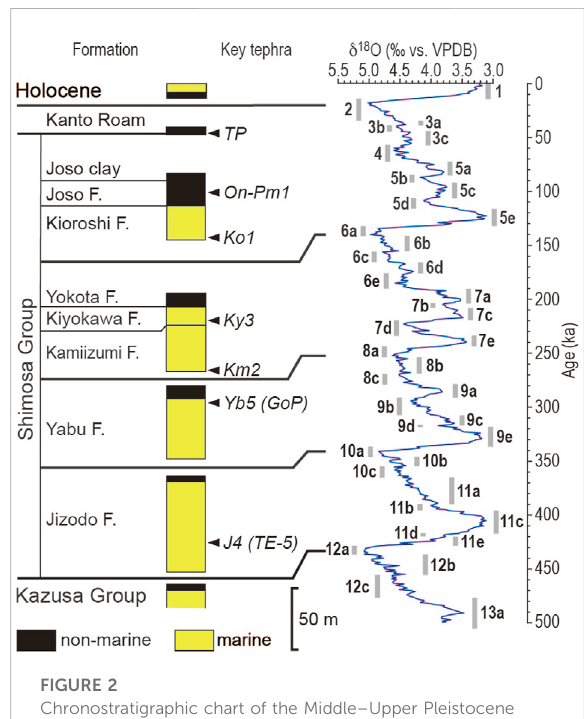
FIGURE 2 Chronostratigraphic chart of the Middle – Upper Pleistocene Shimosa Group and the correlation with the LR04 stack of marine benthic foraminiferal d 18 O data (Lisiecki and Raymo, 2005)and the marine isotopesubstages(Railsback etal.,2015)accordingto Nakazato and Sato.